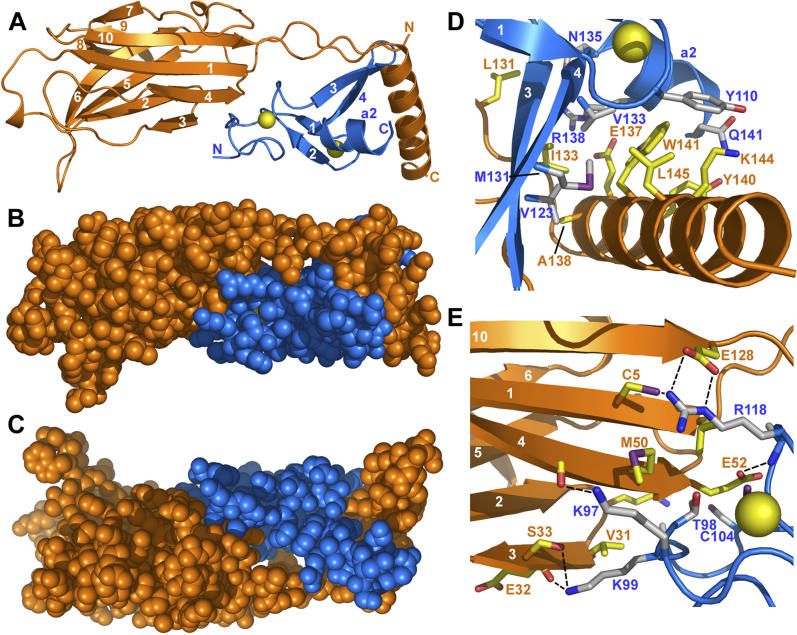
Mode of Munc13–1/RIM2α ZF Domain Binding(A) Ribbon diagram of the complex formed by RIM2α
82–142 (blue) and monomer A of Munc13–1
3–150(K32E) (orange), with the zinc atoms shown as yellow spheres. The β-strands are labeled with numbers, and the α-helix at the C-terminus of the ZF domain is labeled a2. The N- and C-termini are indicated with N and C, respectively.
(B) and (C) Space-filling models of the same complex shown in the same orientation as (A) and after rotating approximately 180° around the horizontal axis (C).(D) and (E) Interfaces of the RIM2α ZF domain with the Munc13–1 C-terminal α-helix (D) and C
2A domain (E). The side chains from residues involved in intermolecular contacts and the Cα carbons of the same residues are shown as stick models, with oxygen atoms in red, nitrogen atoms in blue, and sulfur atoms in purple; Cα carbons are shown with the same color as the ribbon, and other carbons are shown in gray for RIM2α
82–142 and in yellow for Munc13–1
3–150(K32E). Backbone carbonyl groups involved in selected hydrogen bonds (dotted lines) are also shown as stick models. For simplicity, other hydrogen bonds are not shown.